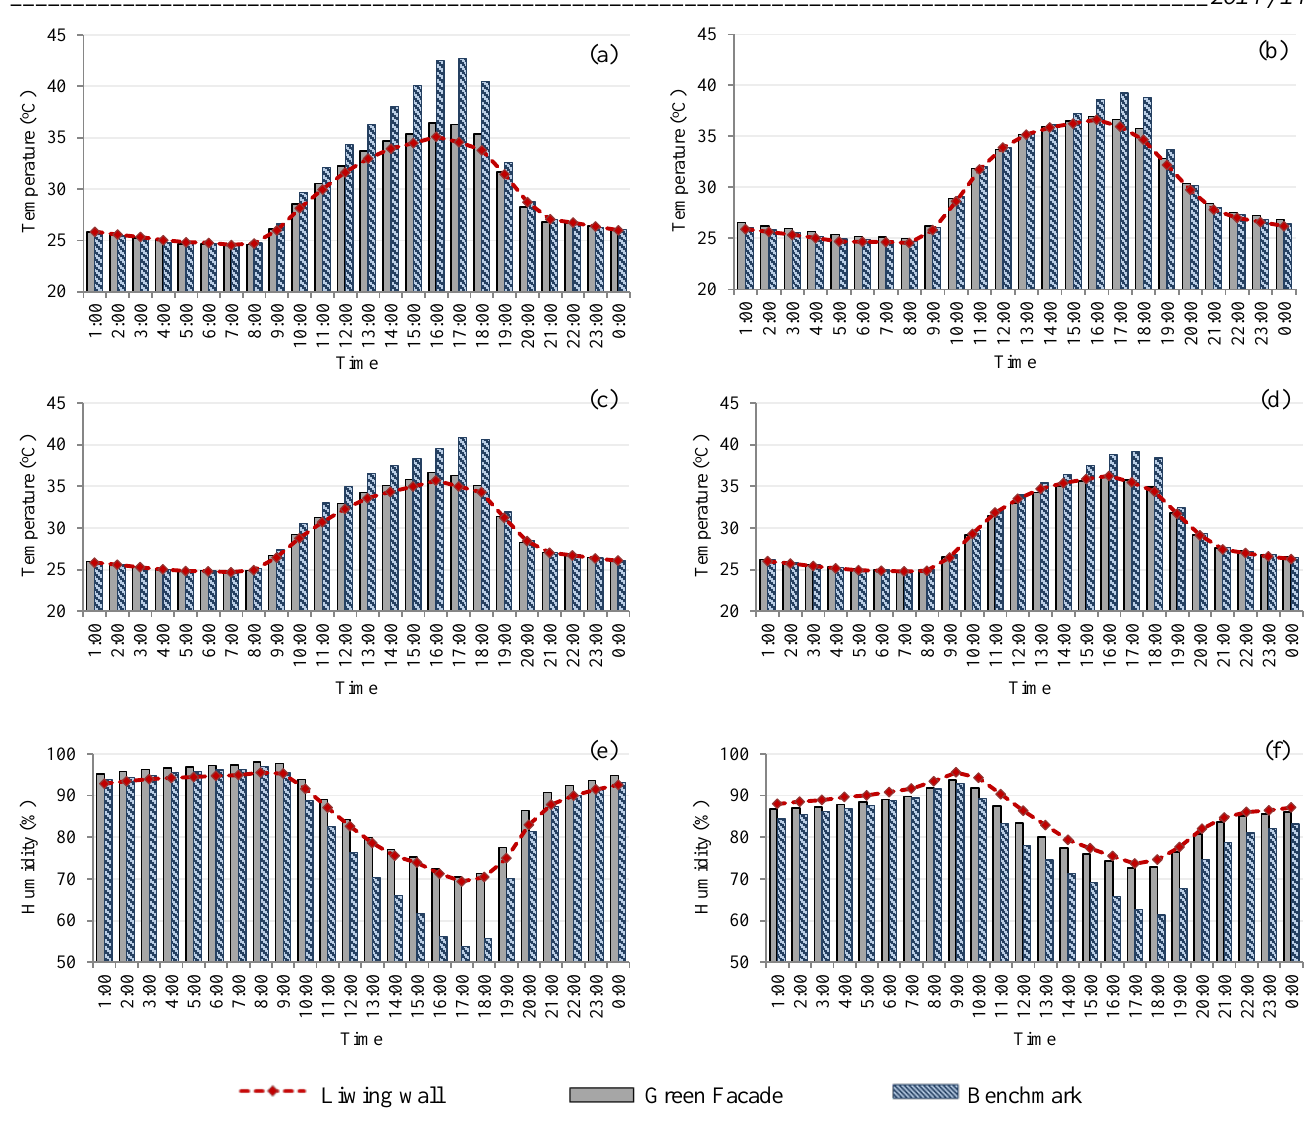
Fig. 4. Comparison between test boxes with living wall, green facade and benchmark for cavity air temperature (a), inside air temperature (b), cavity surface temperature (c), inside surface temperature (d), cavity humidity, and inside humidity